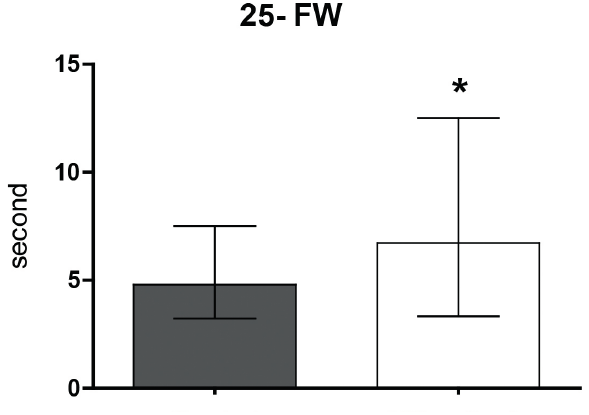
Figure 1 - Timed 25-Foot Walk for the MS and control groups. Values represented in median with interquartile range (P25-P75). *represents a significant difference from the control group (Mann- Whitney test, p < .05 n = 10).